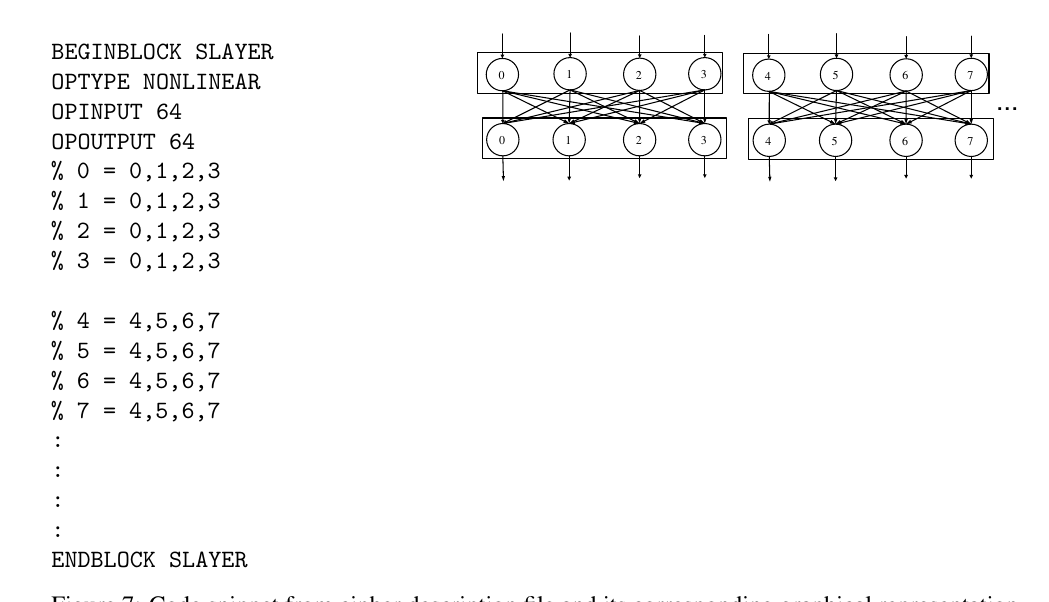
Figure 7: Code snippet from cipher description file and its corresponding graphical representation -----------------------------------------------------------